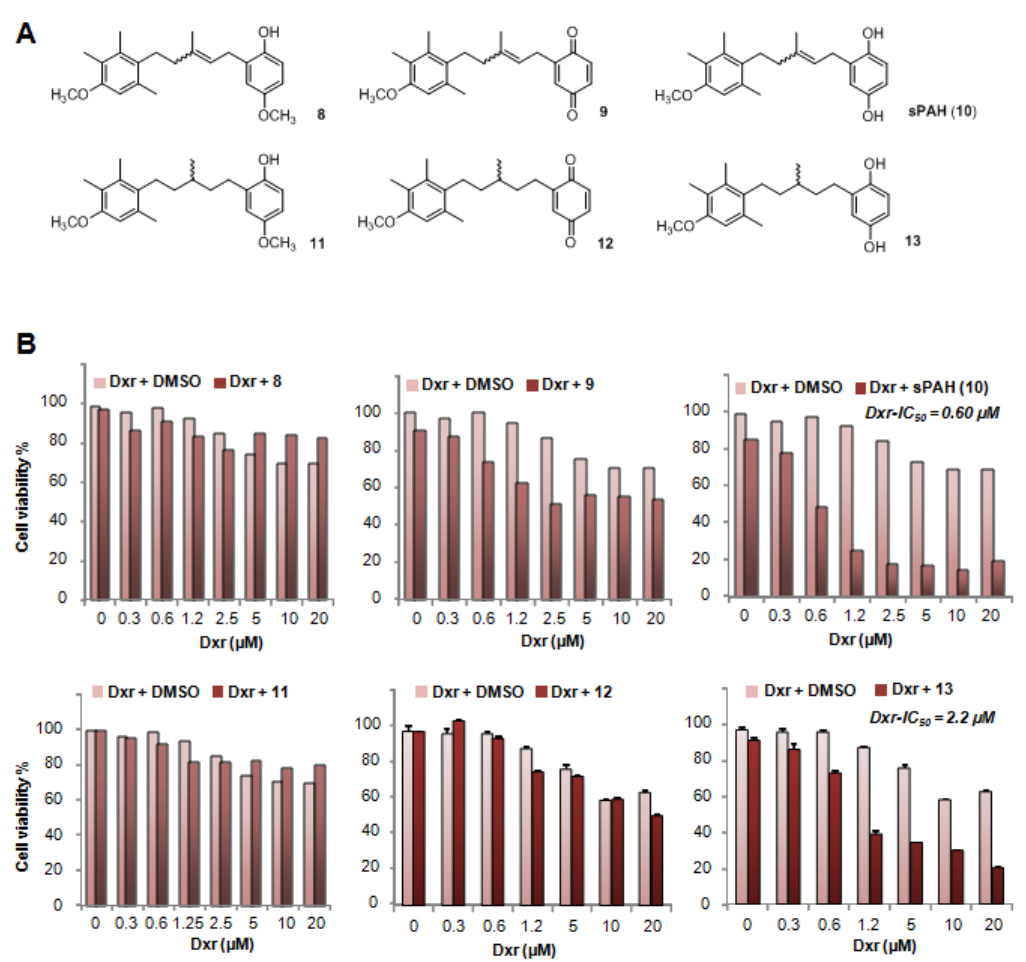
Figure 3. The hydroquinone moiety of PAH is essential to increase doxorubicin efficacy. ( A ) PAH precursors and analogues . ( B ) Effect of PAH precursors and analogues on dxr cytotoxicity . Cell viability was measured after treatment with increasing concentration of dxr in the presence of DMSO or 20 µM sPAH (10), PAH precursors 8 and 9, or PAH analogues 11, 12, and 13 in MeWo cells. Dxr-IC 50 values calculated in the presence of sPAH or PAH analogue 13 are presented.